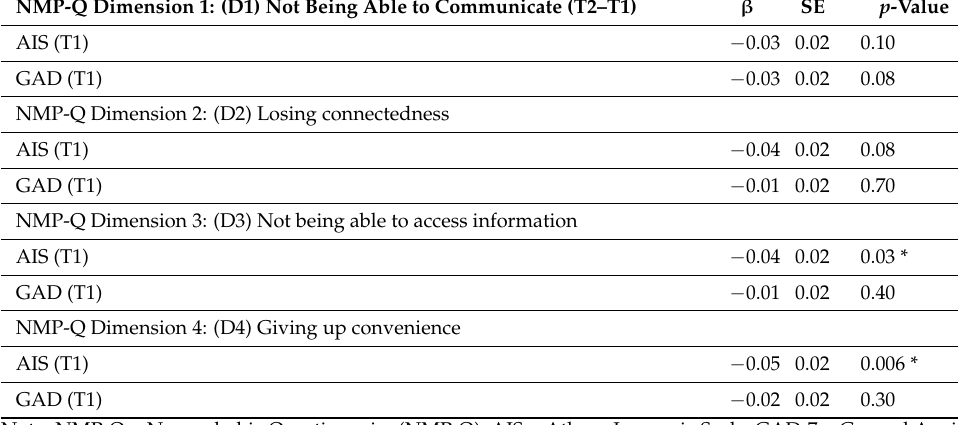
Table 5. The association between AIS and GAD-7 scores at baseline (T1) with the change in the four dimensions of the NMP-Q symptoms during the social media outage